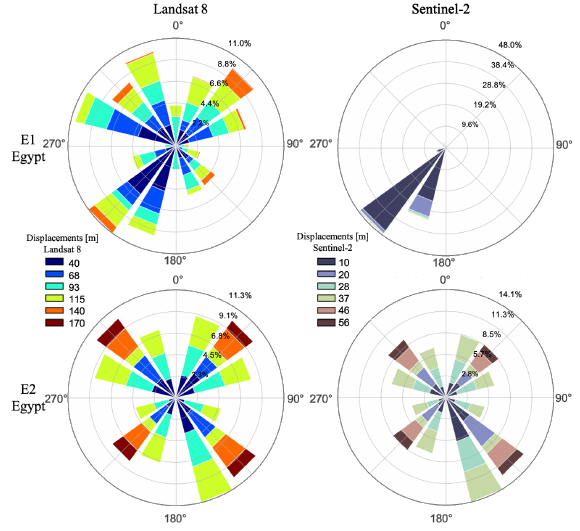
Figure 5. Results synthesis for the experiment E1 and E2 (Table 2) on the Egypt study area